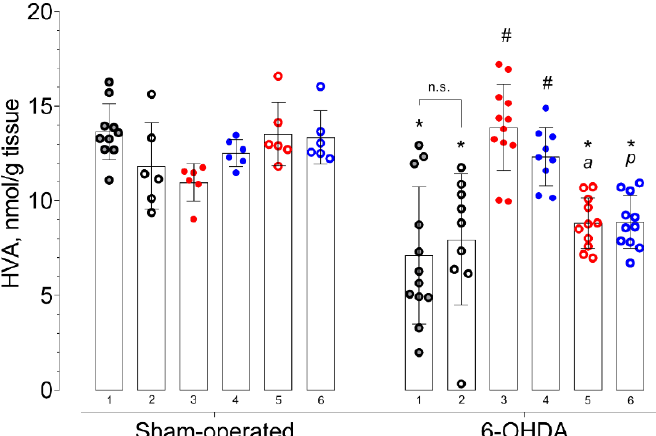
Figure 3. Influence of deferred administration of afobazole over 14 days on HVA content in 6-OHDA-lesioned ICR mice striata. Data are presented as mean ± S.D. Sham-operated—ipsilateral striatum of sham-operated animals. 6-OHDA—ipsilateral striatum of animals with 6-OHDA lesion. Experimental groups were divided by treatment, tissue harvesting and last drug administration were 1-h spaced apart: 1 vehicle. 2 BD-1047 3.0 mg / kg. 3 afobazole 2.5 mg / kg. 4 PRE-084 1.0 mg / kg. 5 BD-1047 3.0 mg / kg and afobazole 2.5 mg / kg. 6 BD-1047 3.0 mg / kg and PRE-084 1.0 mg / kg. Two-way experimental groups except for afobazole (3) and PRE-084 (4). Statistical significance: * p < 0.01 vs. sham-operated vehicle-treated mice. # p < 0.01 vs. 6-OHDA-lesioned vehicle-treated mice. a p < 0.01